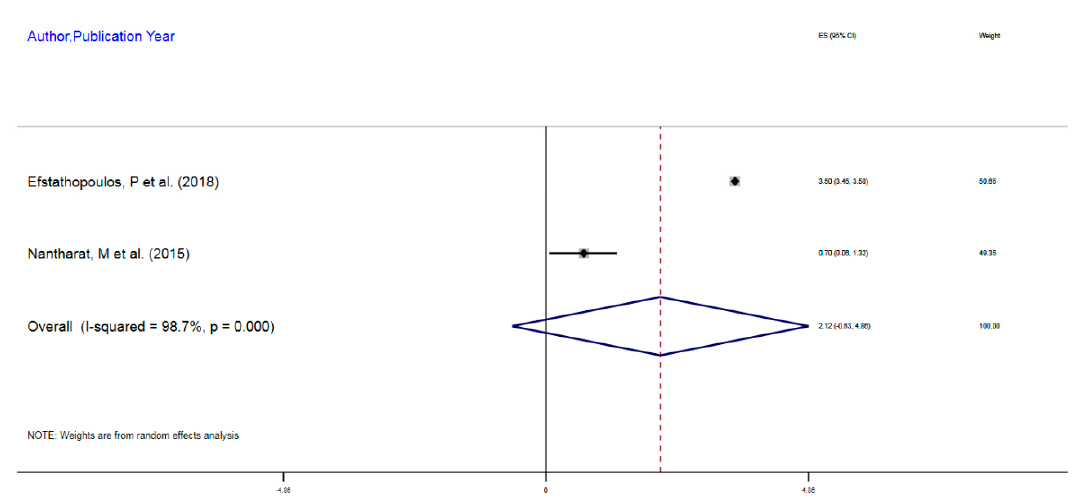
Figure 5. DNA Methylation of NR3C1 (glucocorticoid receptor gene) in Major Depressive Disorder (Unipolar Affective Disorder)